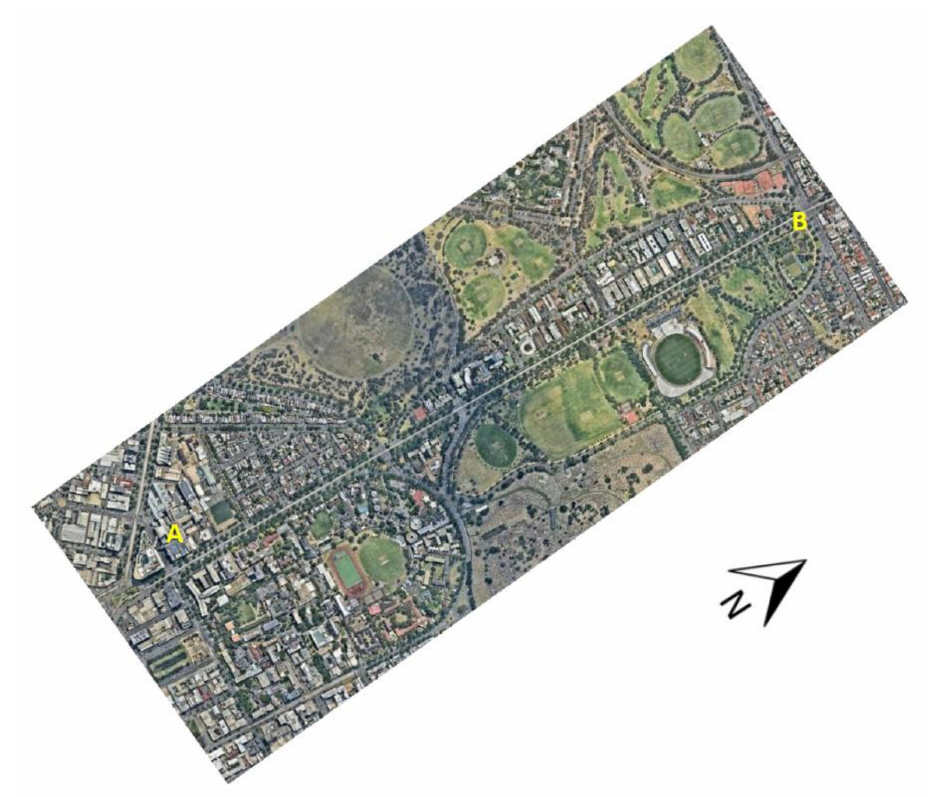
Figure 1. Location monitored using a moving vehicle from ( A ) start of Royal Parade from Grattan Street to ( B ) Park Street (2.52 km), and vice versa. There were 172 trees monitored, consisting of different species of Elm trees ( Ulmus